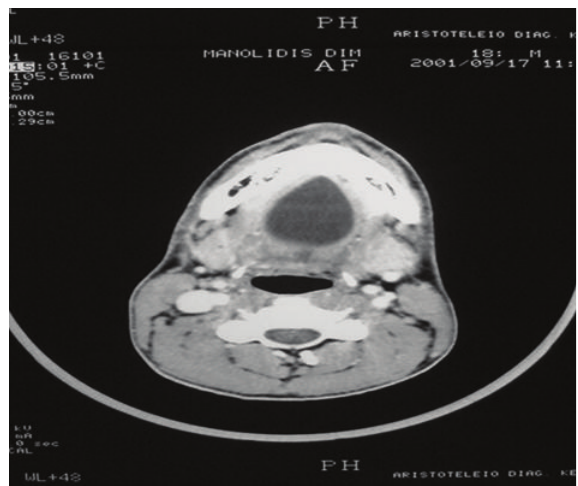
Figure 10: Section of computed tomography (CT) showing a sizeable cystic formation with distinct